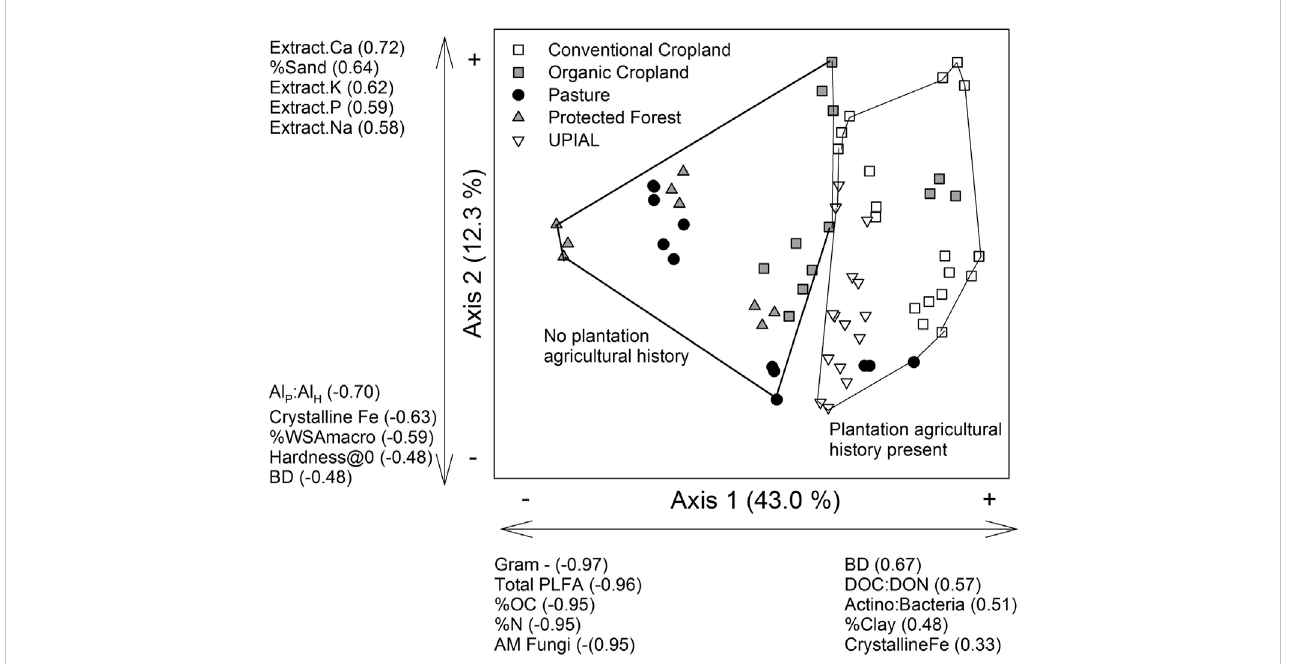
FIGURE 2 Principalcomponentsanalysisofallpotentialsoilhealthindicatorswiththetop fi vemostnegativelyandpositivelycorrelatedvariablestoaxis1andaxis2. Correlation values for each parameter to the axis follow it in parentheses. Groups are delineated based on whether an intensive plantation agricultural history is present or absent at that site. The current land use of each site is also indicated: conventional cropland (white square), organic cropland (grey square), pasture (black circle), protected forest (grey triangle), or unmanaged previously intensive agriculture (UPIAL, upside down white triangle). The amount of variability explained by each axis is in